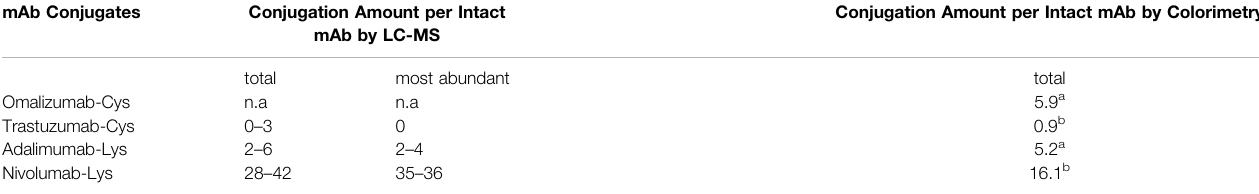
TABLE 1 | Amount of mAb conjugation by intact LC-MS protein analysis and colorimetry.